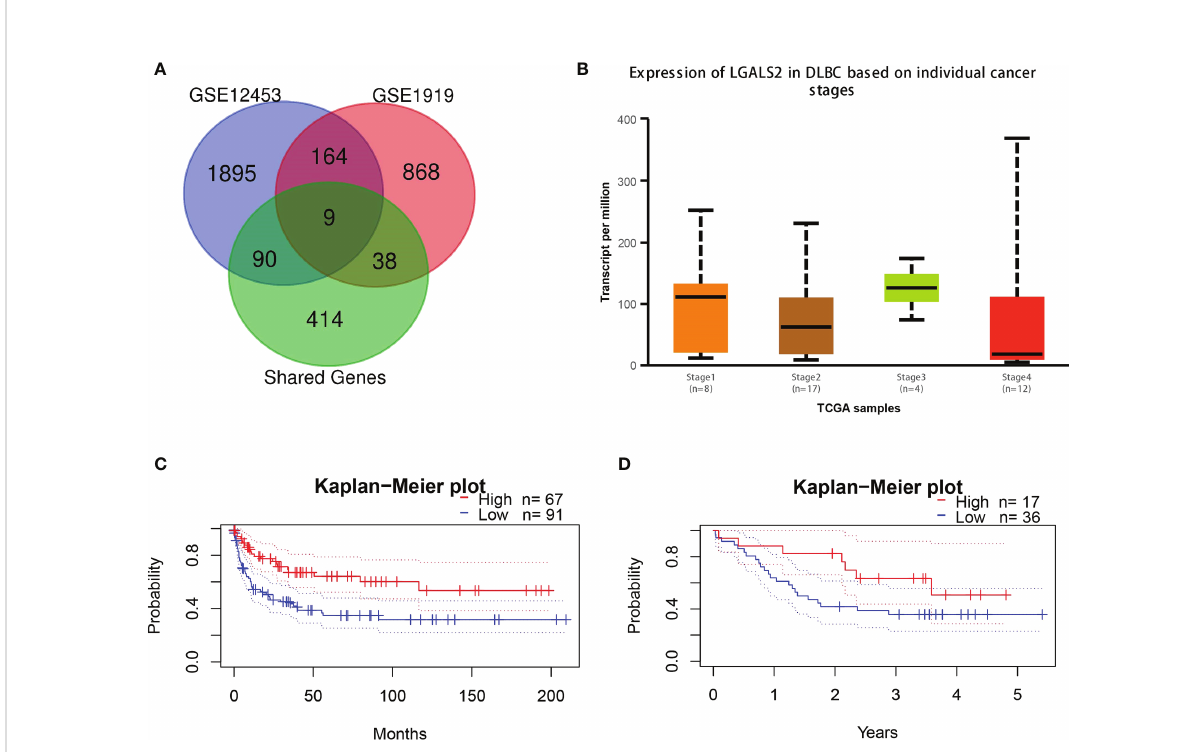
FIGURE 4 LGALS2 expression and prognostic value in DLBCL tissues. (A) Venn diagram of the shared genes in RA and DLBCL in validation cohorts; (B) The expression of LGALS2 in DLBCL at different pathological stages; (C, D) Kaplan – Meier curve of association of LGALS2 and DLBCL patients ’ OS in GSE4475 (C) and E-TABM-346 (D) . RA, rheumatoid arthritis; DLBCL, diffuse large B-cell lymphoma; OS, overall